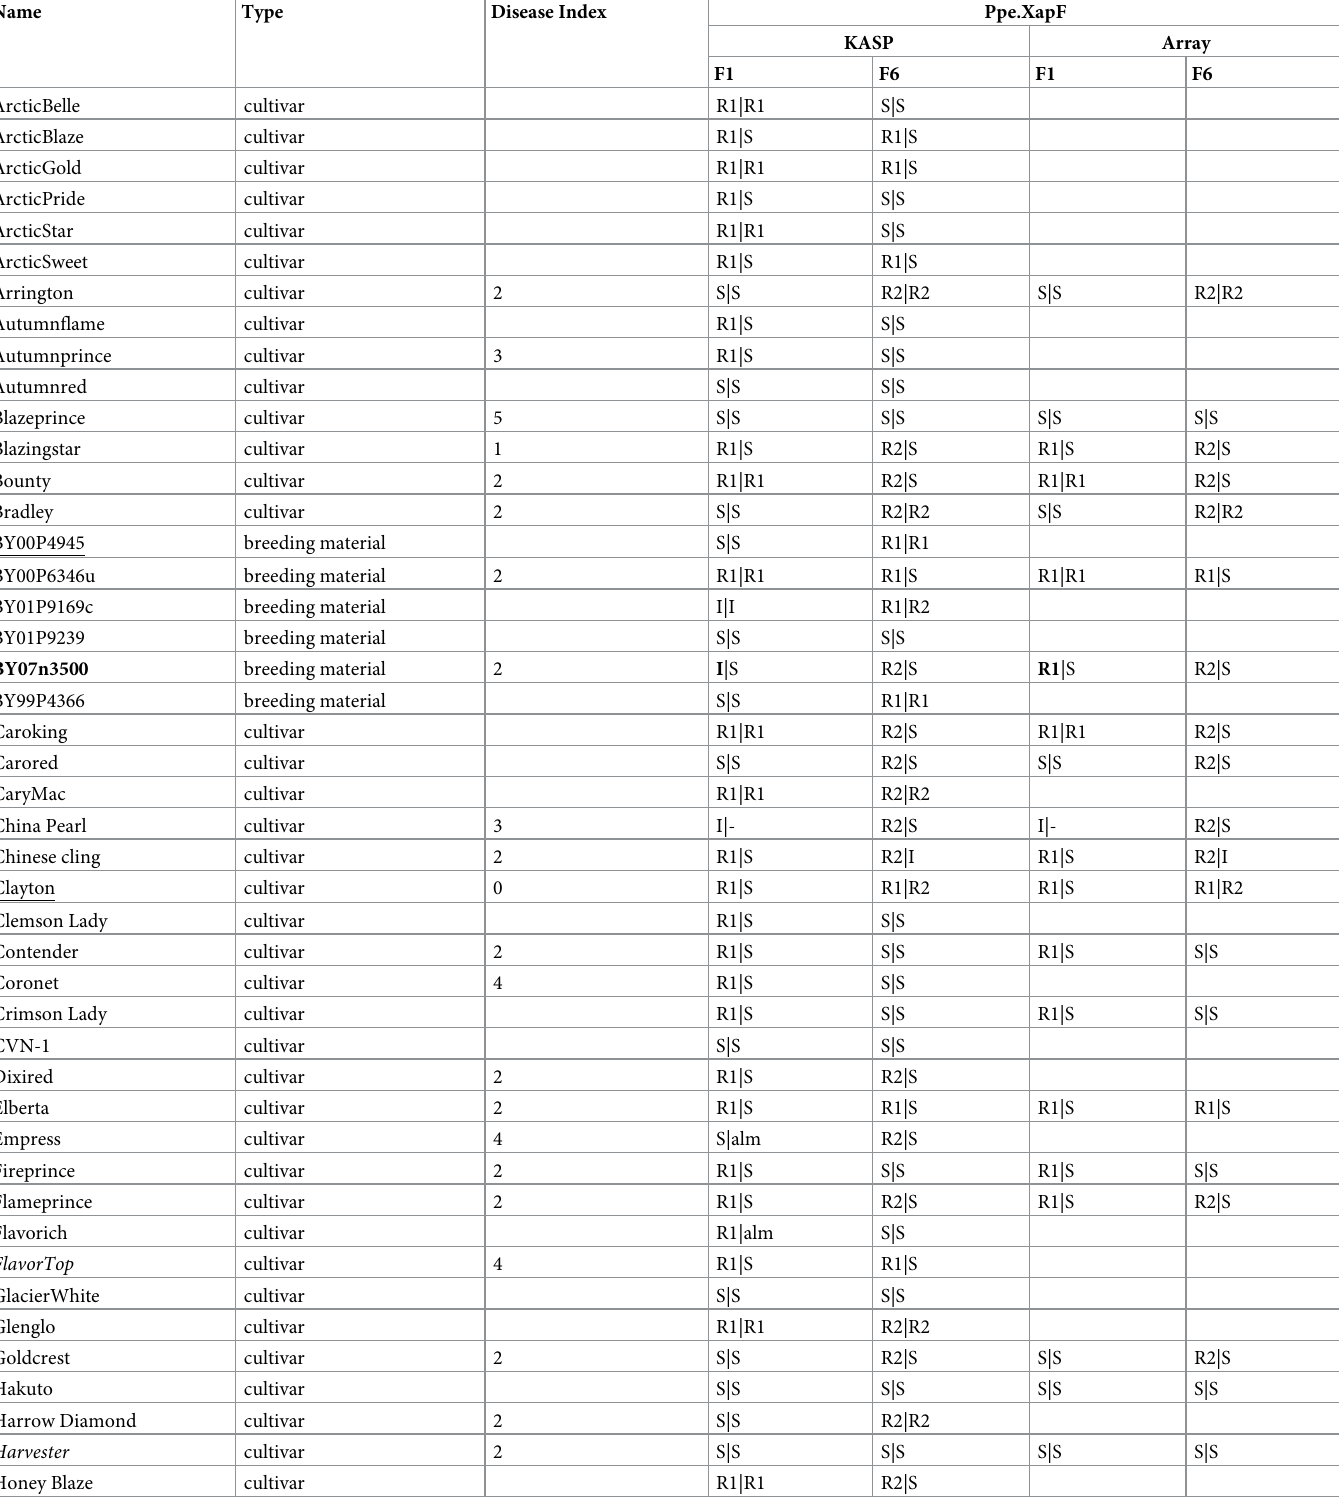
Table 2. Peach germplasm used for development and validation of the Ppe.XapF DNA test. Ppe.XapF genotypes predicted with KASP and 9K IPSC SNP